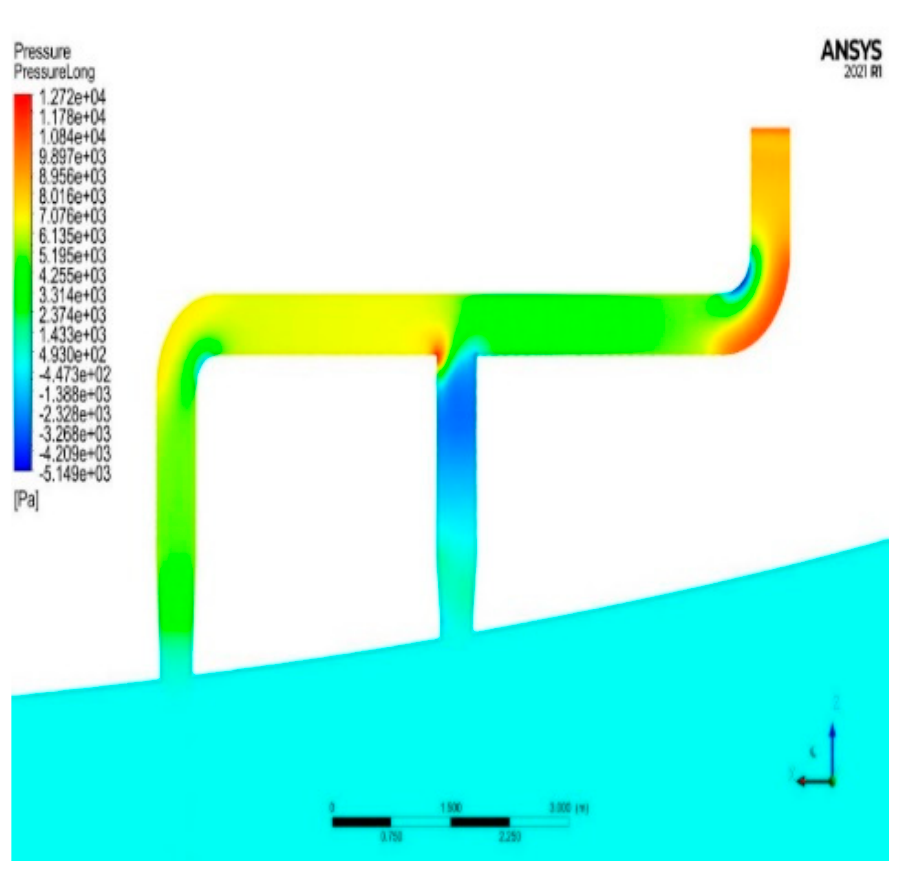
Figure 12. Pressure variation—pipe longitudinal section.